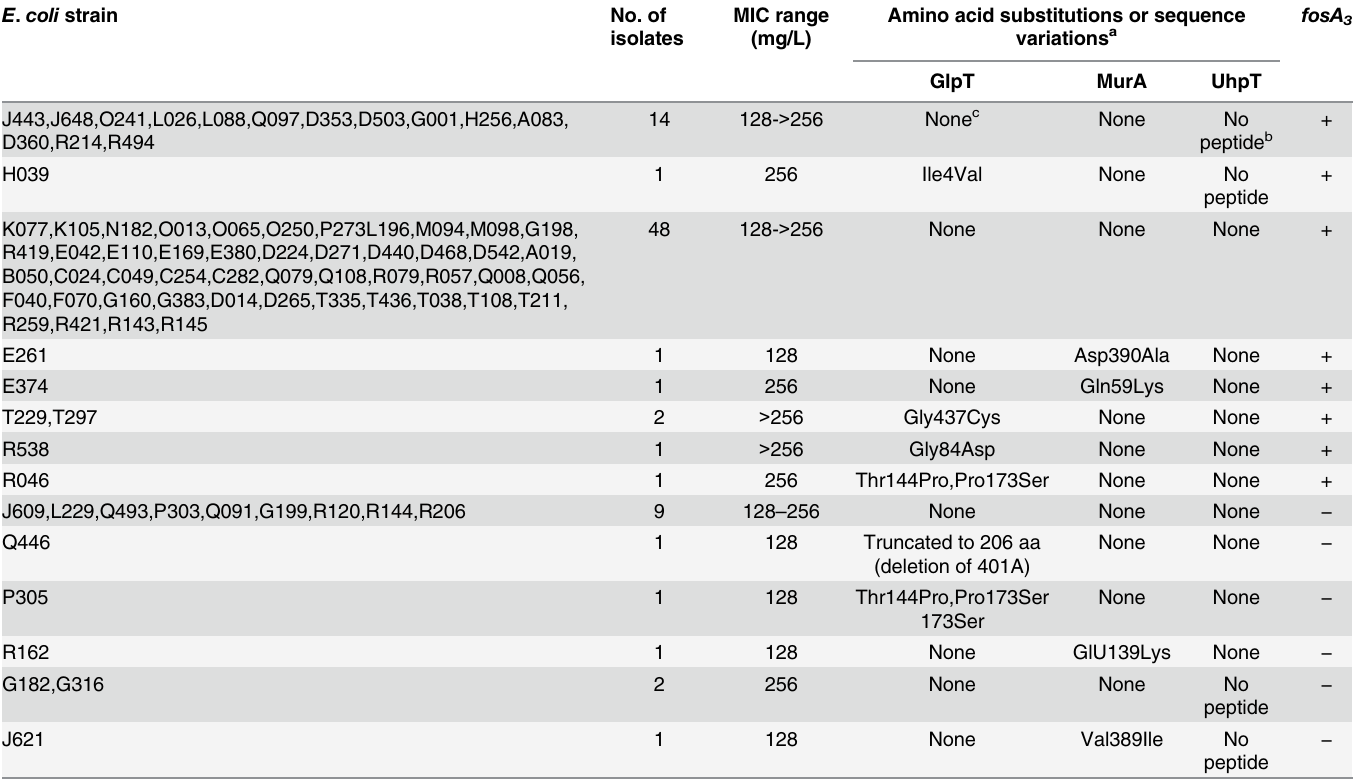
Table 4. Characterization of fosfomycin non-susceptible E . coli isolates.